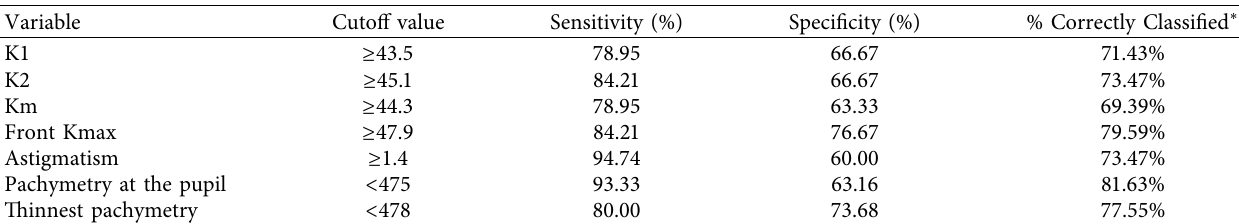
Table 4: Proposed tomographic cutoff values for KCN disease progression in na¨ıve fellow eyes ( N � 49).